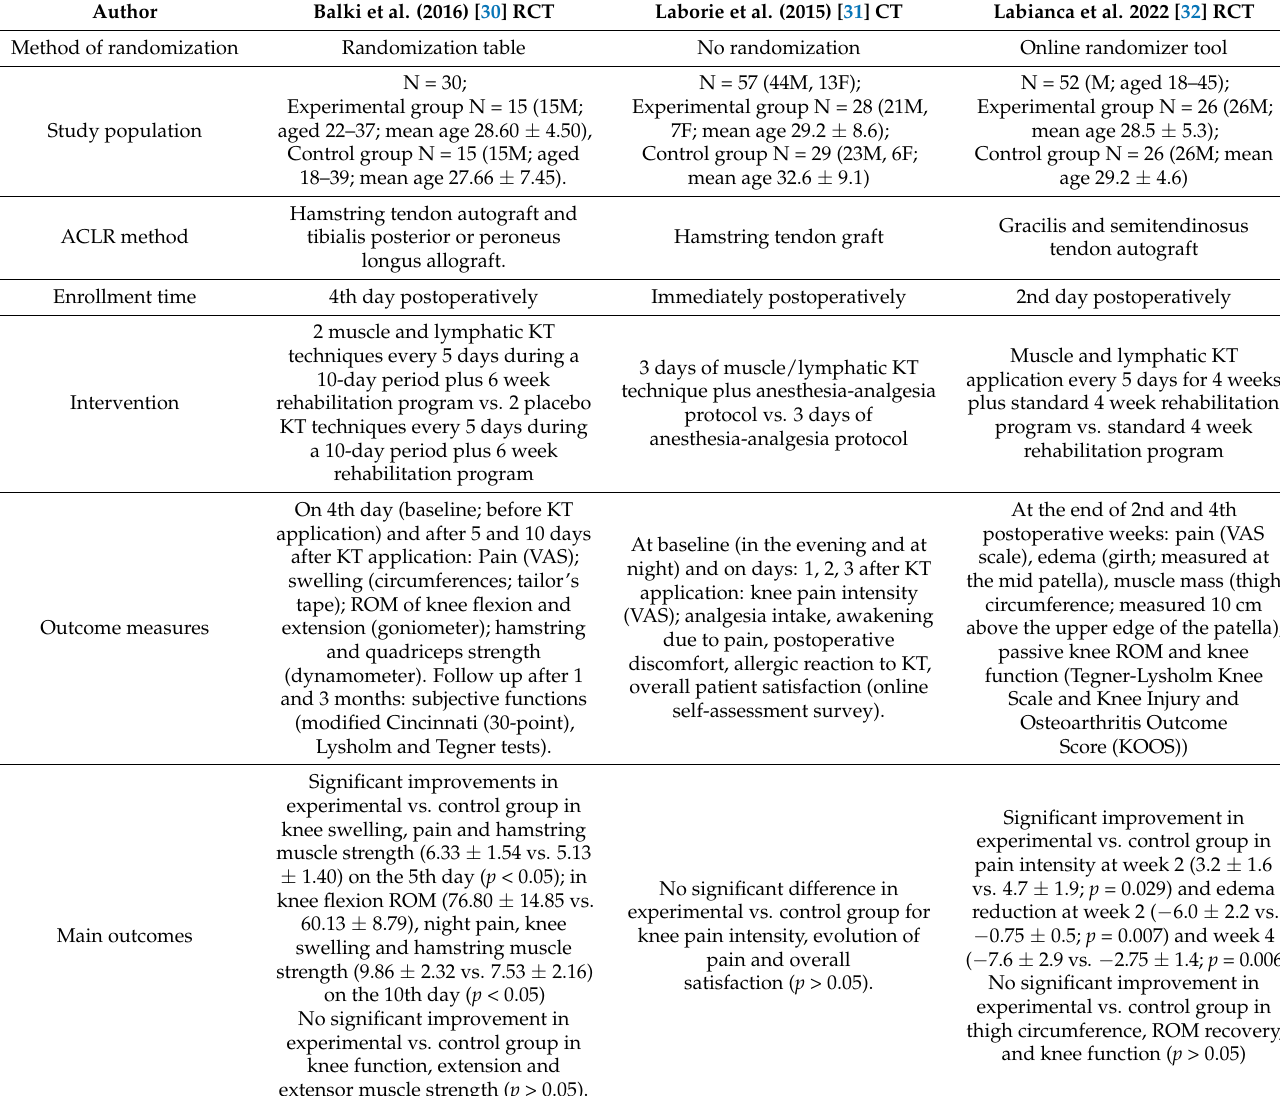
Table 7. Summary of reviewed studies on